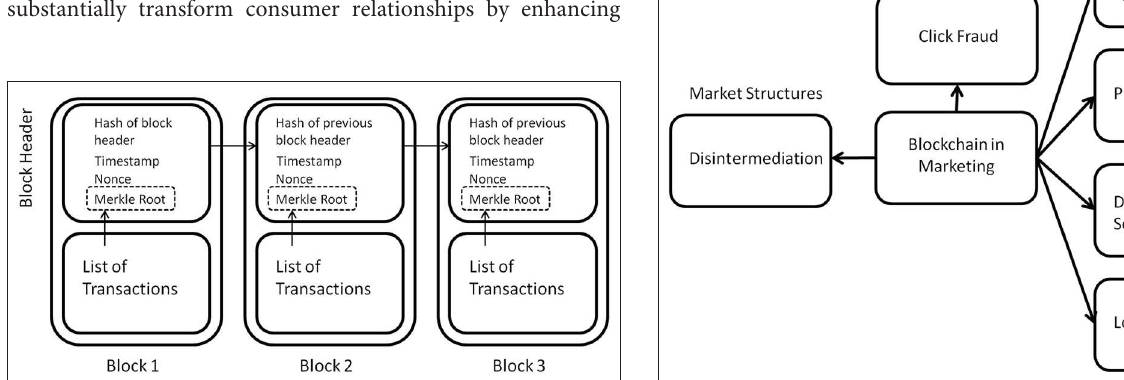
FIGURE 1 | Blockchain structure. FIGURE 2 | Impact of blockchain on